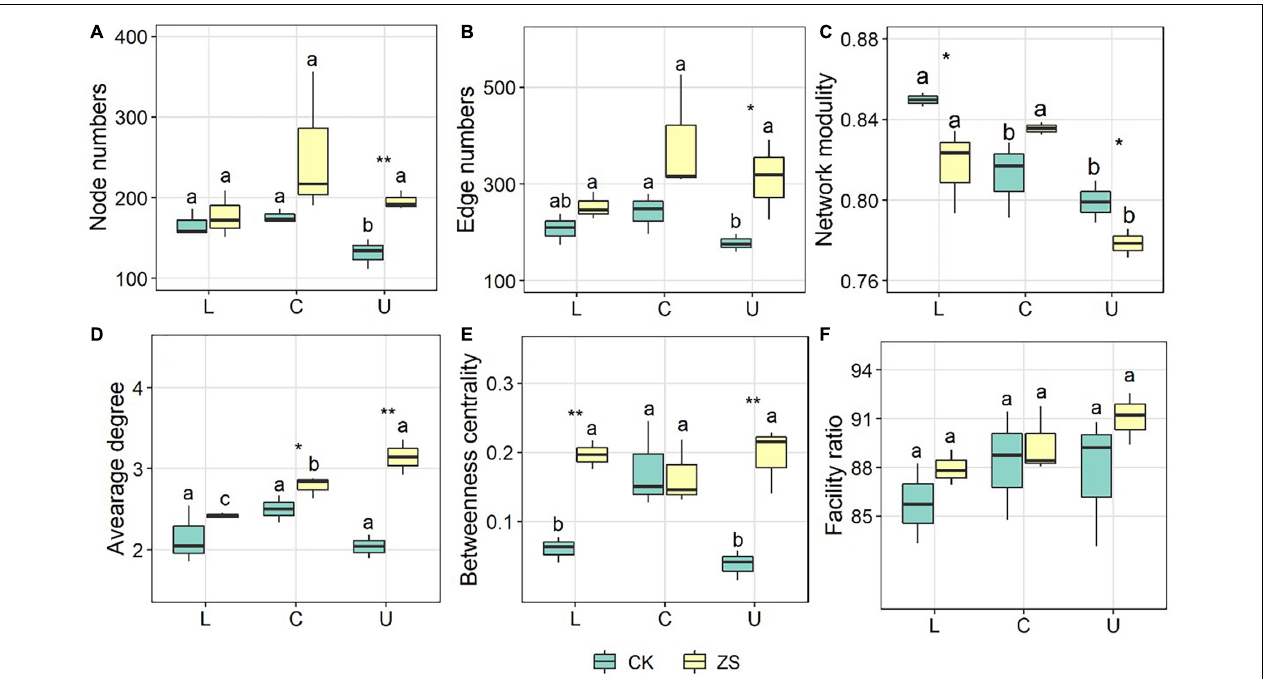
FIGURE 5 | Network features of the endophytic fungal community in ordinary (CK) and nornicotine-enriched (ZS) tobacco leaves at lower (L), center (C), and upper (U) plant sections. Different letters above the boxes indicated significant differences among plant sections from CK or ZS tobacco, while the significant differences between CK and ZS are marked by asterisks ( p < 0.05). (A) node number; (B) edge number; (C) network modularity; (D) average degree; (E) betweenness centrality; (F) facility ratio.